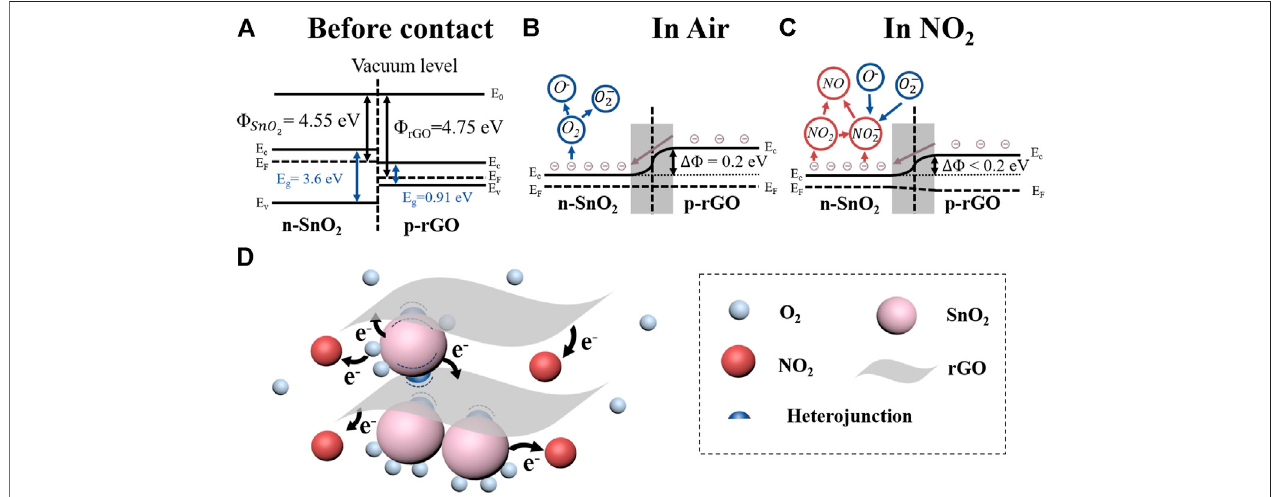
FIGURE5|(A) Schematicbandgapstructure ofn-type SnO 2 andp-type rGO; (B) Schematicbandgapstructure ofSnO 2 /rGOheterojunctioninairand (C) inNO 2 ; (D) Schematic of sensing mechanisms of SnO 2 /rGO composite-based sensors with exposure to NO 2